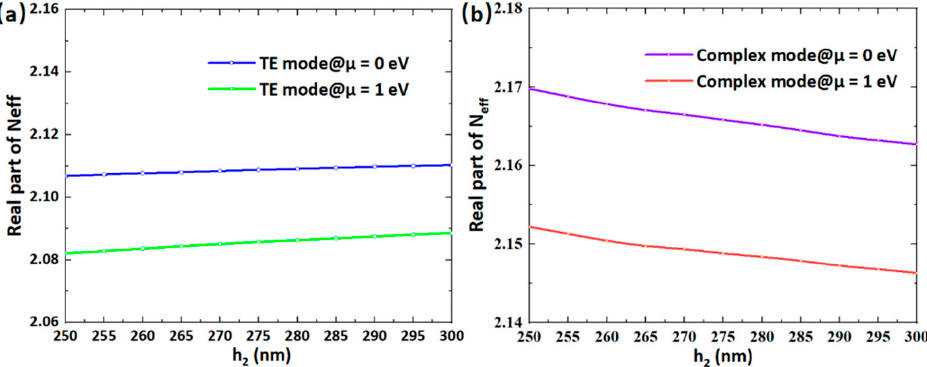
Figure 10. Re( N eff ) as a changing relationship of h 2 for ( a ) TE mode and ( b ) complex mode.